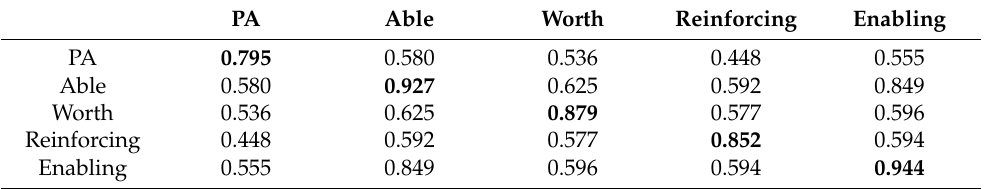
Table 4. Correlations among latent variables, with square roots of AVEs on the main